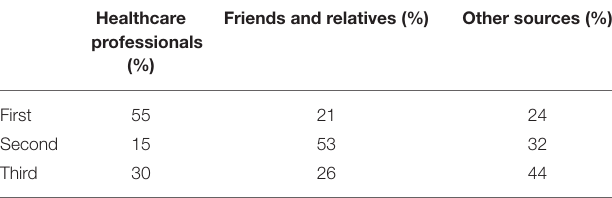
TABLE 5 | Sources of information on vaccines in order of contribution.